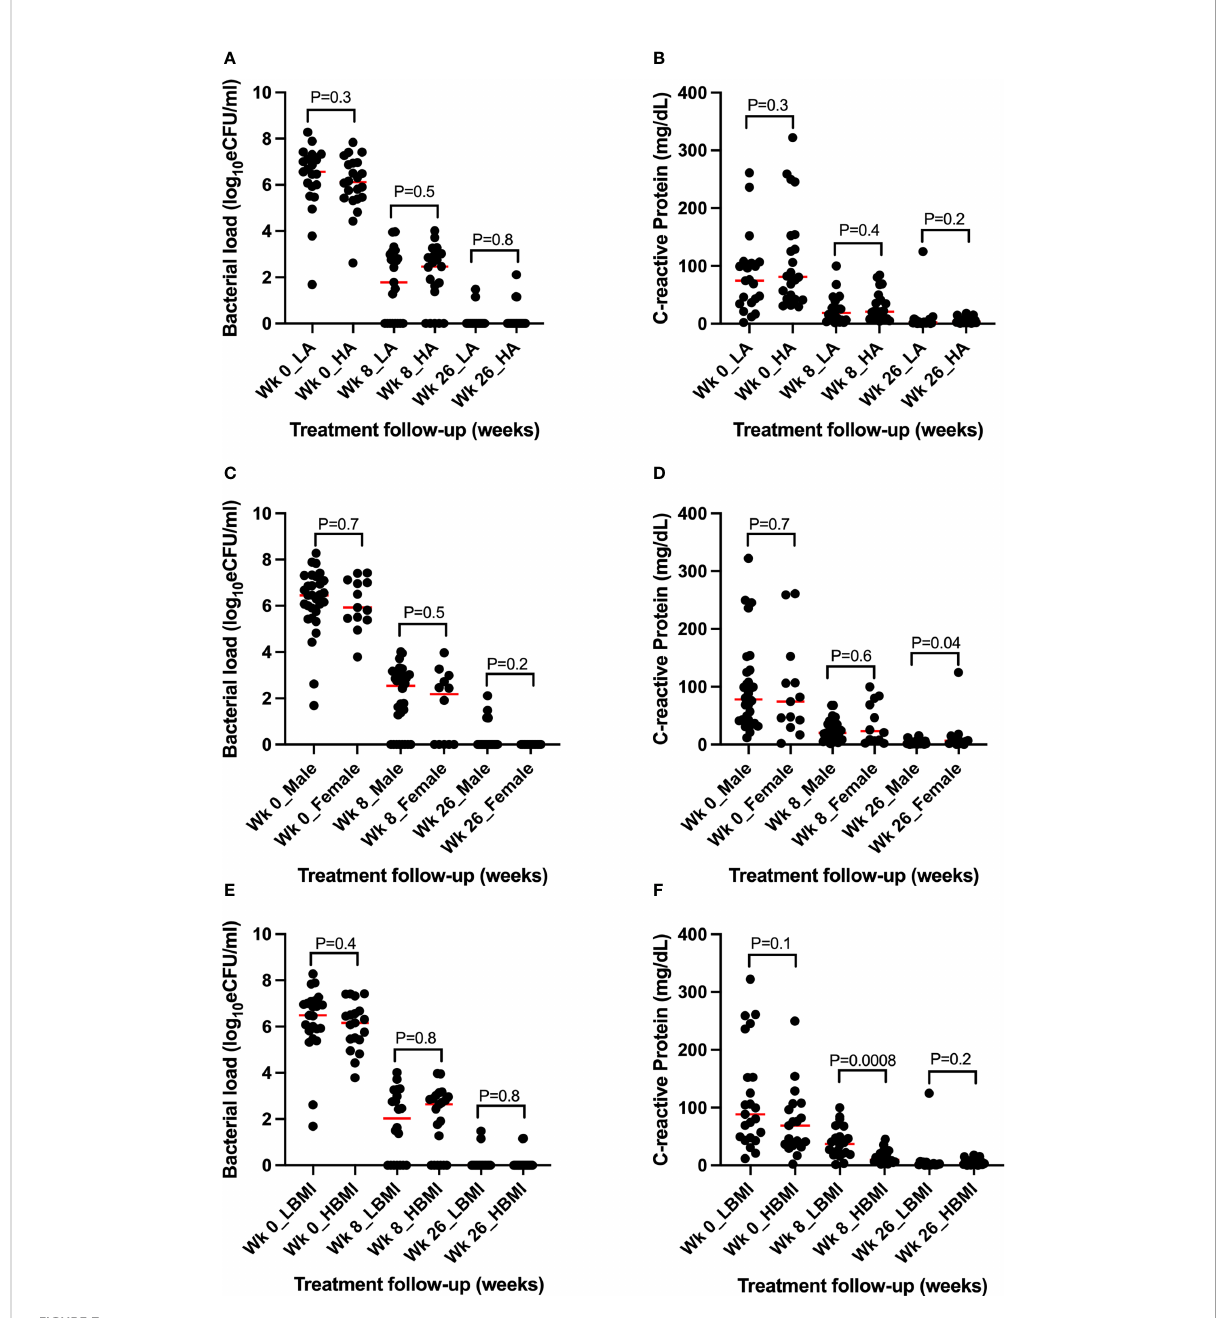
FIGURE 7 Assessment of the role of demographic parameters in TB bacillary load and CRP concentration and resolution before and during treatment. (A, B) Assessment of age revealing no association with bacillary load and CRP concentration and clearance during treatment. (C, D) Assessment of gender showing no association with bacterial load but signi fi cant difference at week 26 between female and male CRP concentration. (E, F) Assessment of BMI showing no association with bacillary load but signi fi cant high CRP among the high BMI participants at week 8 of treatment. WK = week, L = low, H = high, BMI = body mass index, Wk 0 = baseline